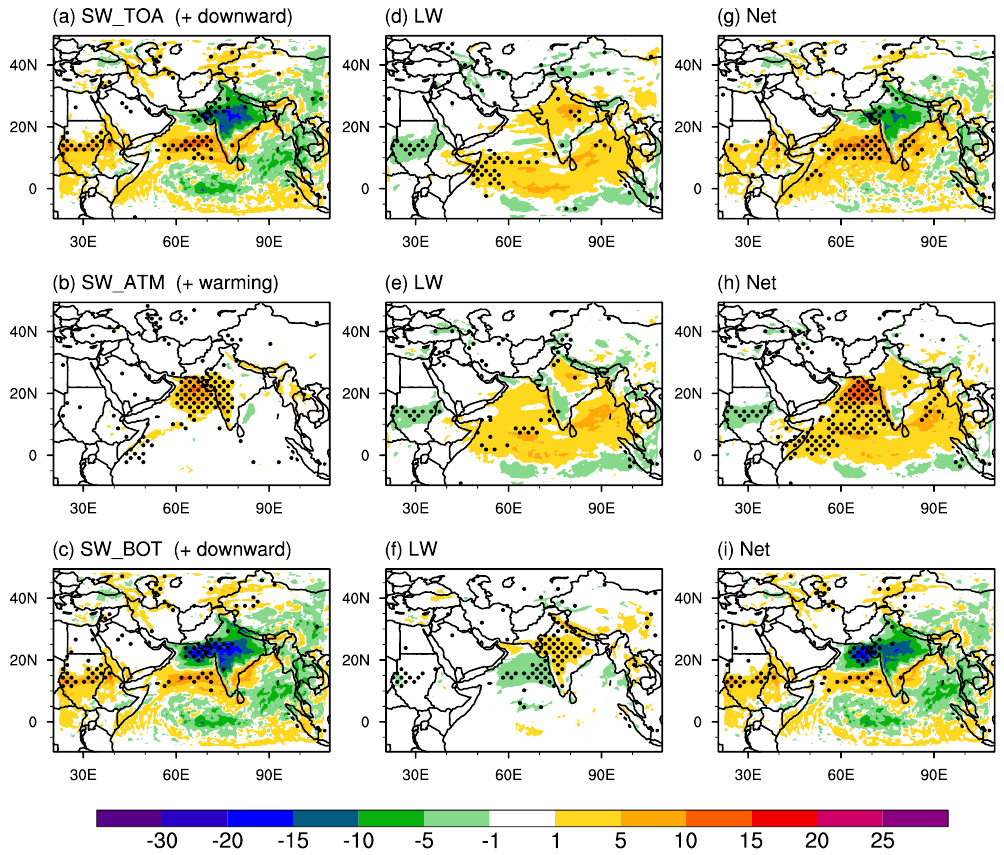
Figure 13. Same as Fig. 11, but for radiative effects (Wm − 2 ) at cloudy conditions, calculated as radiative effects at all-sky conditions minus those at clear-sky